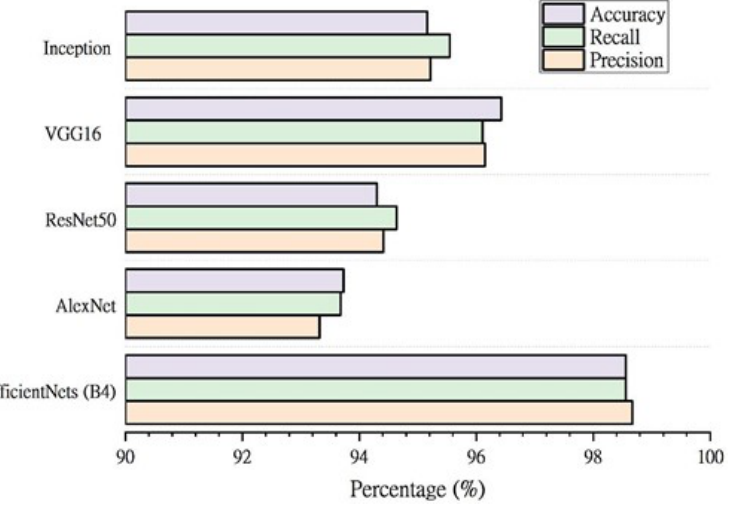
Figure 11. Comparison between the EfficientNet-B4 model and the state-of-the-art